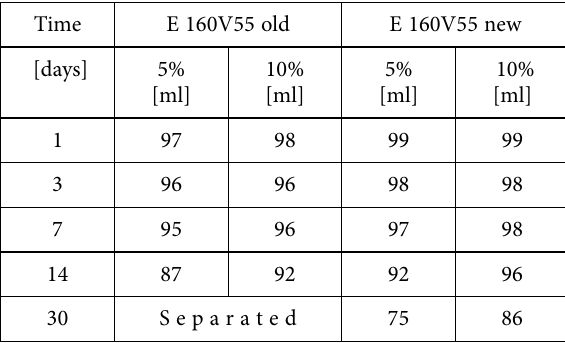
Table 1. Sedimentation of dispersions after dilution to 5% and 10%